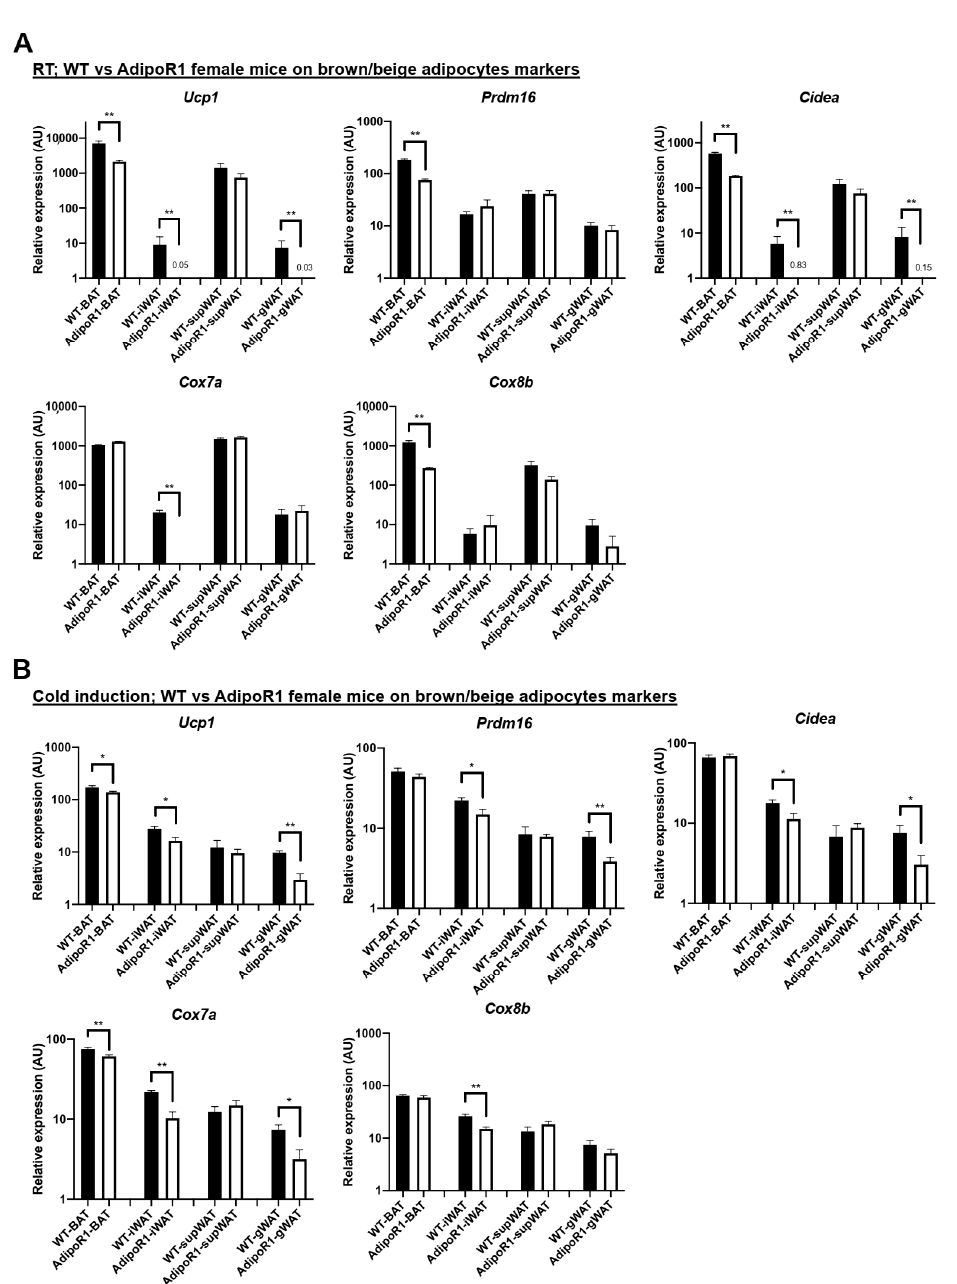
Figure 7. Figure 7. Reduced BAT thermogenic and mitochondrial markers in classical brown and beige adipose depots of AdipoR1 mice before and after cold-stimulation. Expression of brown adipocyte markers and BAT-enriched mitochondrial markers was evaluated in indicated adipose tissues of WT and AdipoR1 female mice, both ( A ) at room temperature (RT) before and ( B ) following the cold exposure at 10 ◦ C. Timeline and procedures were described in Figure 1. Classical iBAT, iWAT, supWAT (both of potential white adipose depots for browning or beiging), and gWAT in WT and AdipoR1 female mice were harvested, extracted, and measured to evaluate cold-induced thermogenic related genes at RT or after cold acclimation ( n = 3–8 for each group). Data were presented as relative means (normalized to β -actin in arbitrary units, AU) ± SEM. * p ≤ 0.05; ** p ≤